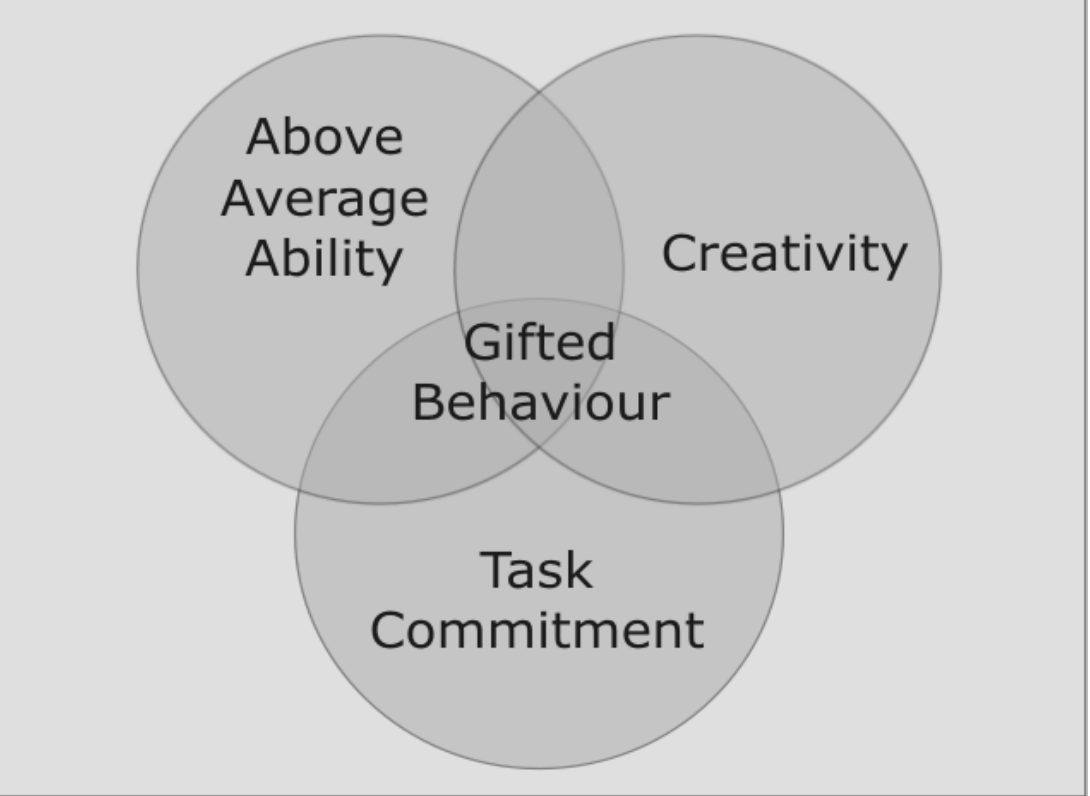
Figure 2.4 Renzulli’s Three Ring Model adapted from Sternberg & Davidson